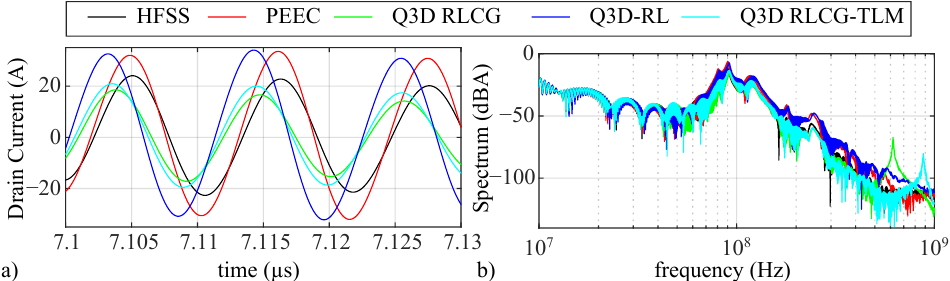
Figure 8. Detailed comparison of current waveforms shown on Figure 7: ( a ) the zoom of all waveforms at the beginning of the switching transition, and ( b ) the spectrum of current switching